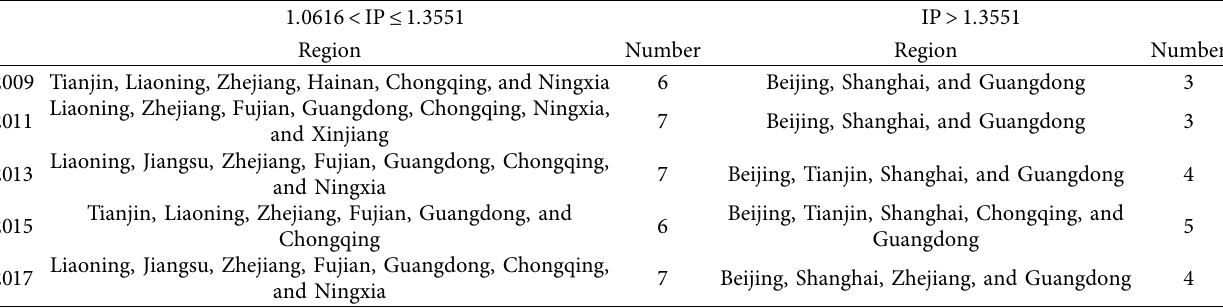
Note. The eastern regions include Beijing, Tianjin, Hebei, Shanghai, Jiangsu, Zhejiang, Shandong, and Guangdong; the central areas include Anhui, Jiangxi, Henan, Hubei, and Hunan; the western areas include Chongqing, Sichuan, Guizhou, Shaanxi, and Gansu. The northeast region includes Heilongjiang and Liaoning; other regions were not included in the sample due to serious data